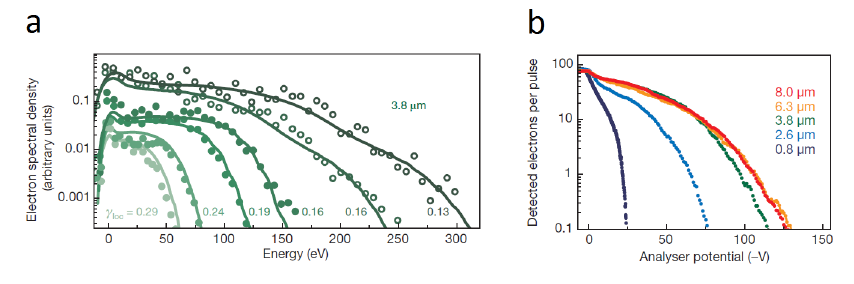
Figure 12. ( a ) Experimental (circles) and simulated (solid lines) kinetic energy distributions of photoelectrons emitted from the nano-tips for increasing intensities at a wavelength of 3.8 µ m; ( b ) Electron energy distribution as a function of the wavelength. Curves represent the number of electrons with energies above the analyzer potential. Adapted with permission from [105], Copyright NPG,